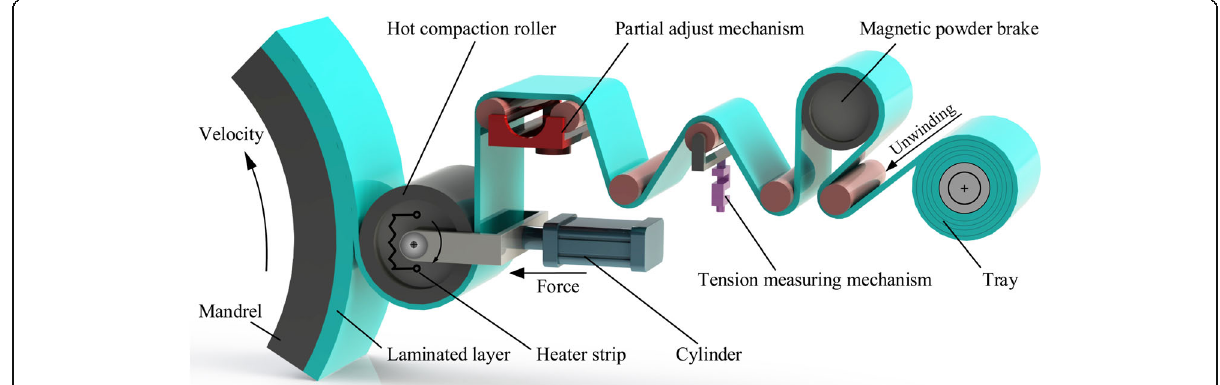
Fig. 1 Three-dimensional diagram of composites prepreg tape winding process